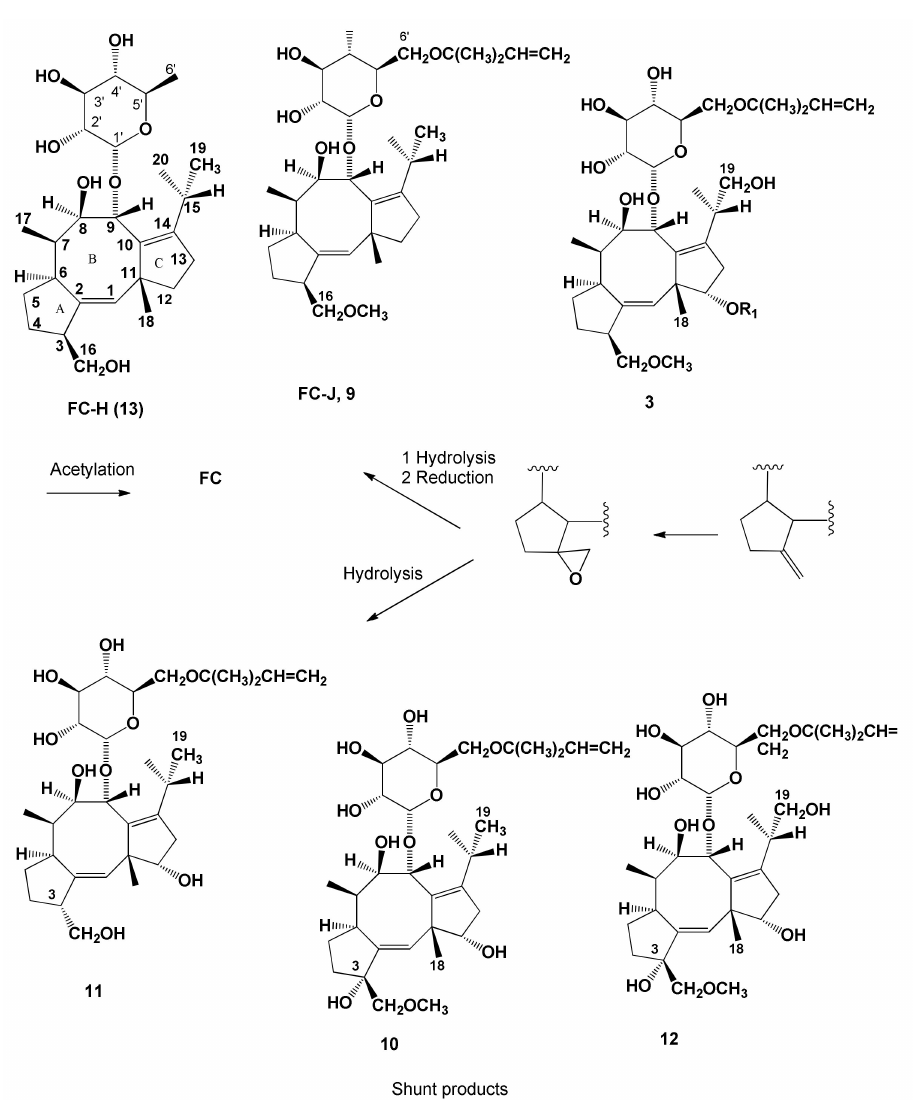
Figure 6. The successive steps of functionalization of the carbotricyclic 5:8:5 diterpenoid glucosylated intermediate in the FC biosynthesis, and related minor metabolites and shunt biosynthetic